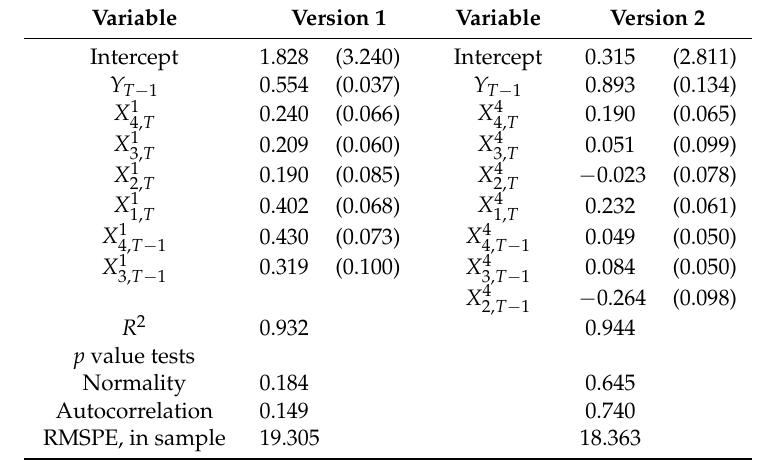
Table 4. Estimation results for the (unrestricted) MIDAS regression models, sample runs from 1975 to and including 2015. Estimated Newey-West adjusted standard errors are in parentheses. X 1 first-order differenced median stamps prices, where T again corresponds with years and q with the quarters 1, 2, 3, and 4, and differenced median stamps price. X 4 median stamps